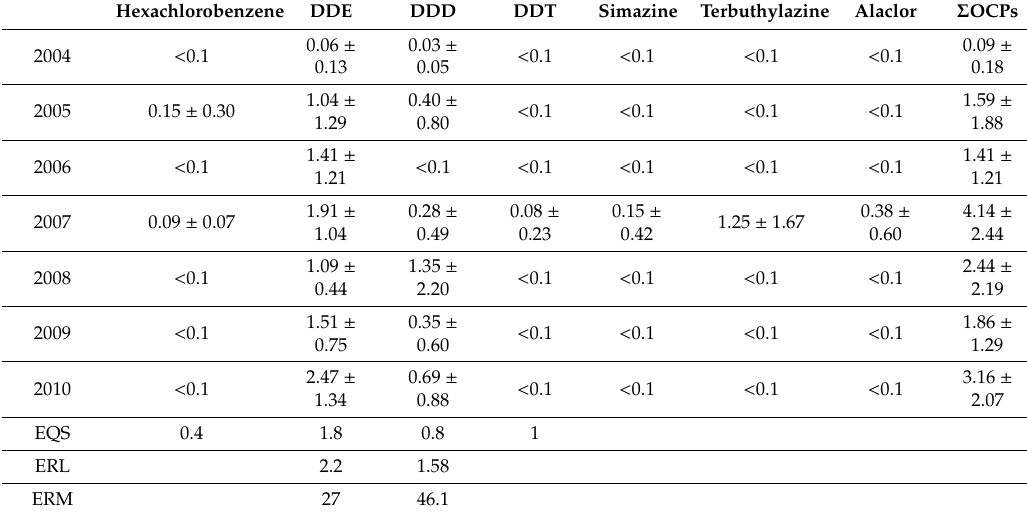
Table 2. Mean ( ± SD) annual organochlorine pesticides (OCPs) concentrations ( µ g / kg) in sediments of Sacca di Goro (n = 4). The EQS according to the WFD and D.M. 260 / 2010. Hexachlorobenzene DDE DDD DDT Simazine Terbuthylazine Alaclor Σ